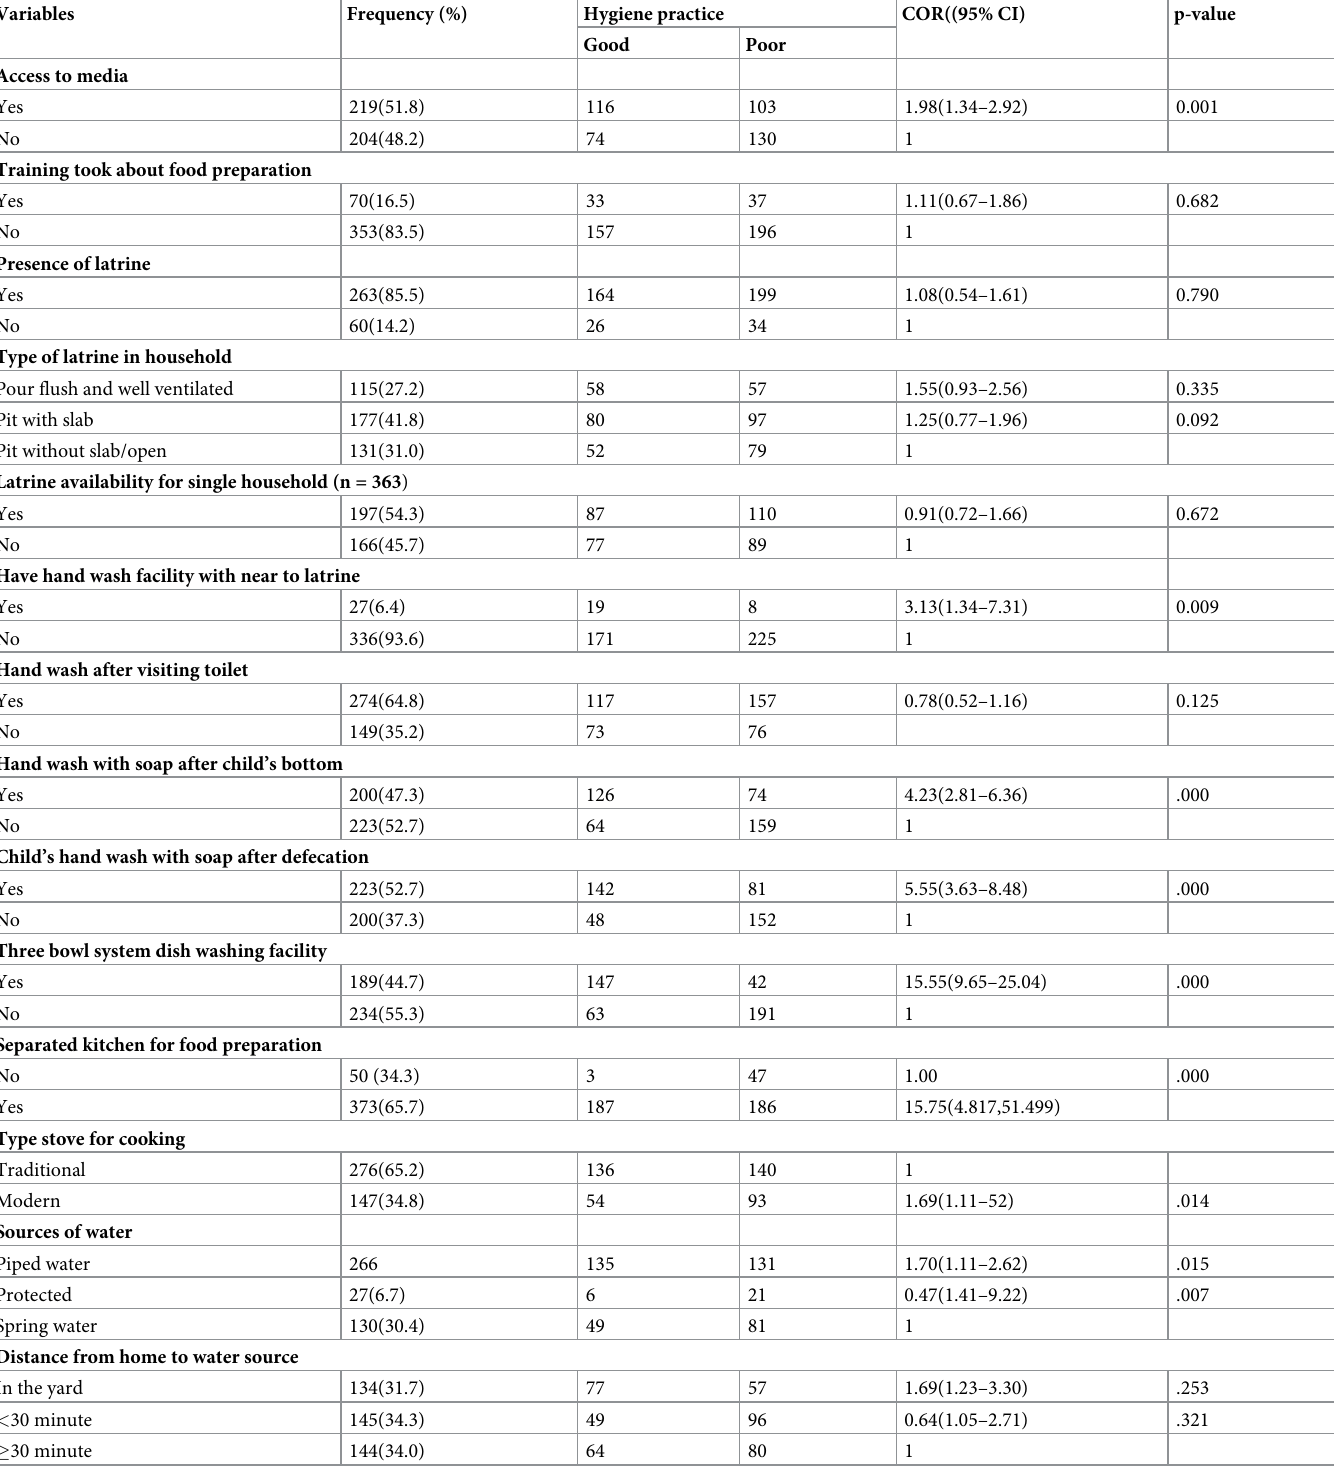
Table 3. Bivariate analysis of the association of environmental and housing related factors with hygiene practice in complementary food preparation among moth- ers with 6–24 months aged of children in Debark town northwest Ethiopia, 2021(n =